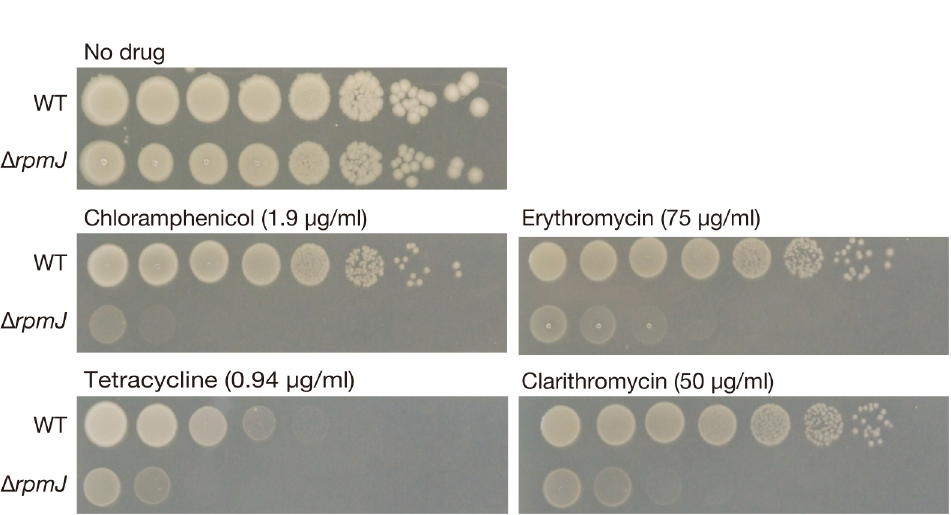
Fig 2. The rpmJ mutant is sensitive to protein synthesis inhibitors. Overnight cultures of the wild-type strain (WT) and the rpmJ mutant ( Δ rpmJ ) were serially diluted 10-fold, spotted onto LB agar plates with or without chloramphenicol (1.9 μ g/ml), erythromycin (75 μ g/ml), tetracycline (0.94 μ g/ml), or clarithromycin (50 μ g/ml), and incubated overnight at 37˚C.